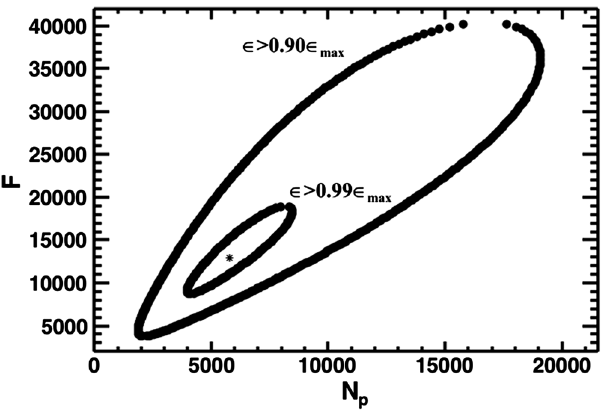
FIG. 3. Optimum values for F and N p and contour plots delimiting areas where ϵ > 0 . 90 ϵ N e ¼